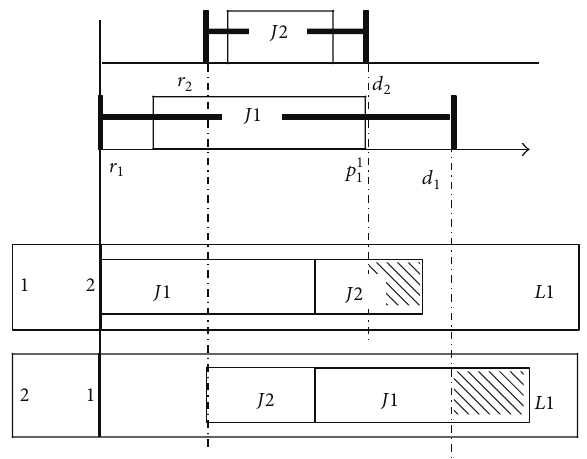
Figure 5: The “cut” for an infeasible cable assignment. time the IP solver is called; otherwise, it will generate the same scheme as the